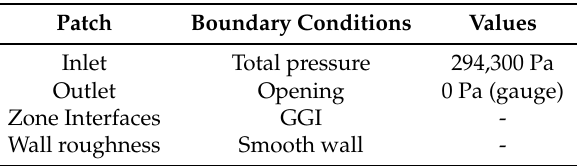
Table 4. Boundary conditions used in the numerical analysis.